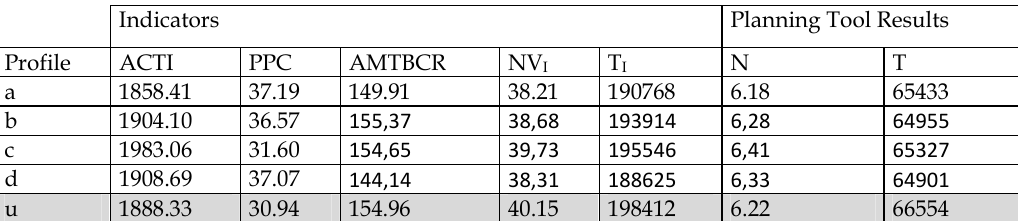
Table 2. Average values of the indicators for Set 2.